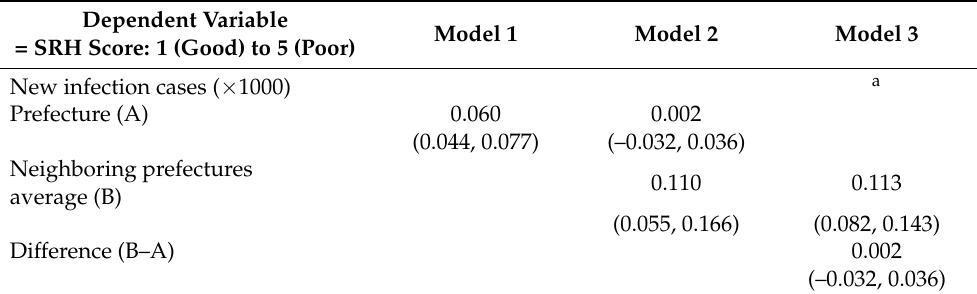
Table 3. Estimated association between new COVID-19 cases and self-rated health (SRH) score a ( N = 4520 observations of 2260